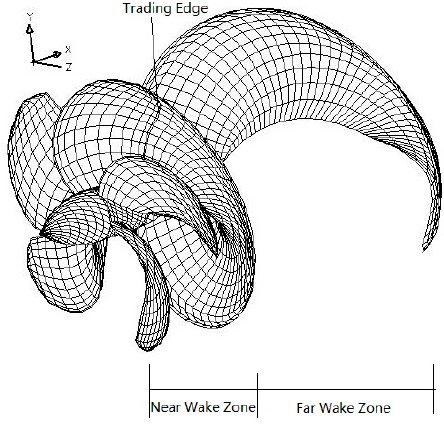
Figure 4. KP505 schematic diagram.